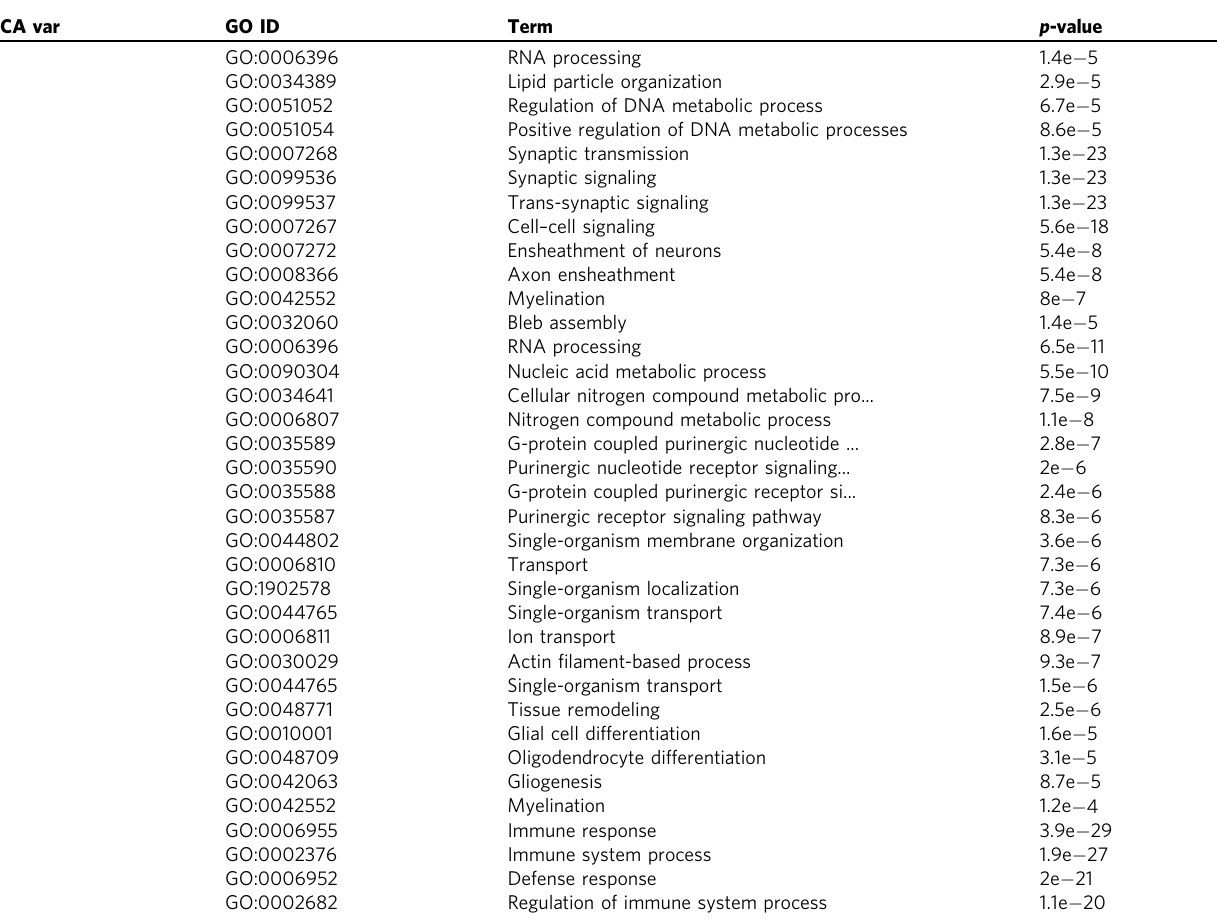
Table 1 Enriched GO terms for genes selected by sparse CCA in the LGG